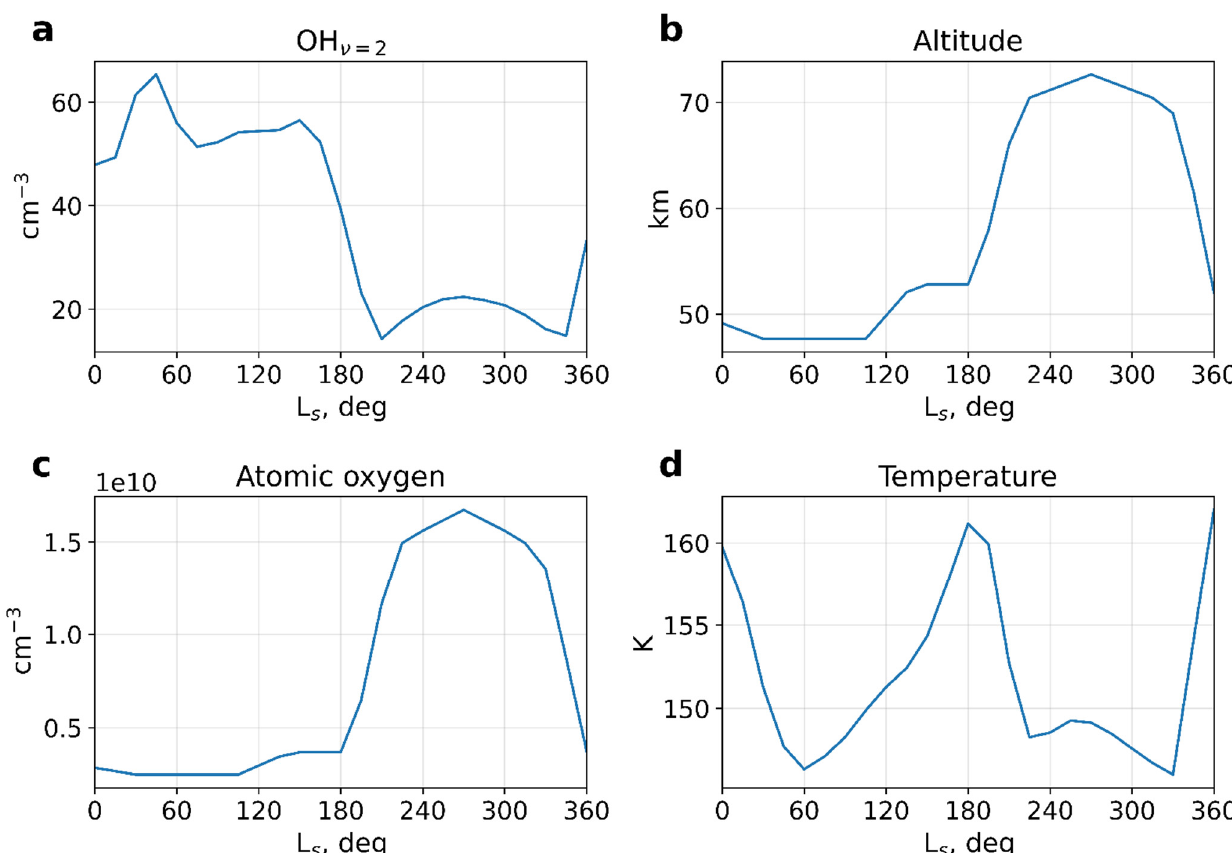
Figure 2. Night-time mean one-month sliding averaged values at the peak of the OH v = 2 layer calcu-lated with (1) at middle (40° N) latitudes: ( a ) concentration [OH v = 2 ], ( b ) the height of the peak, ( c ) atomic oxygen concentration, and ( d ) temperature.